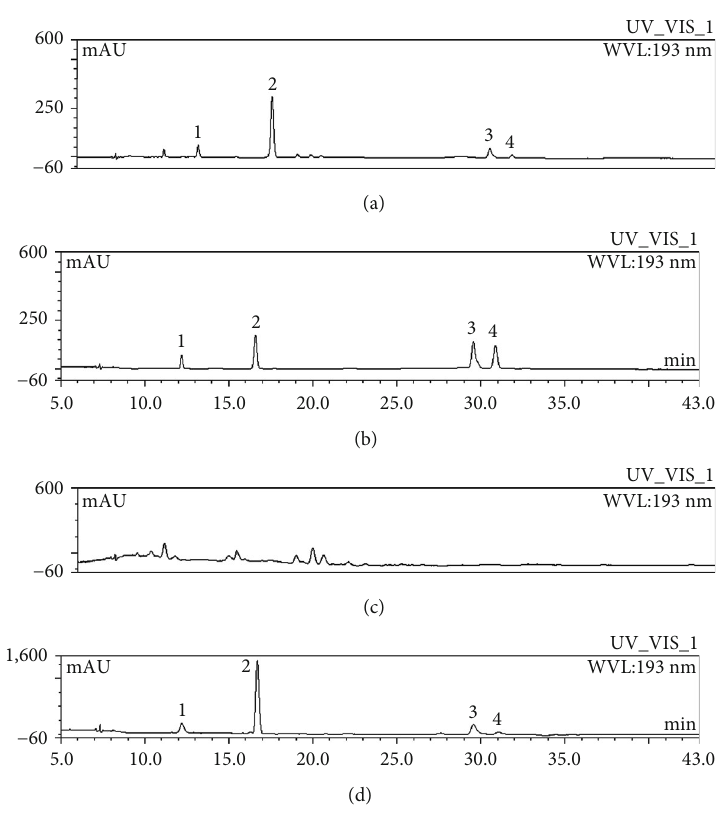
Figure 1: HPLC characterization of the EFBS (a). Standards were prepared in our laboratory, with purity greater than 98% (b). KO-EFBS (c). MC1-4 (d). 1 – 4 represent coelonin, batatasin III, 3 ′ - O -methylbatatasin III, and 3-hydroxy-5-methoxy bibenzyl,